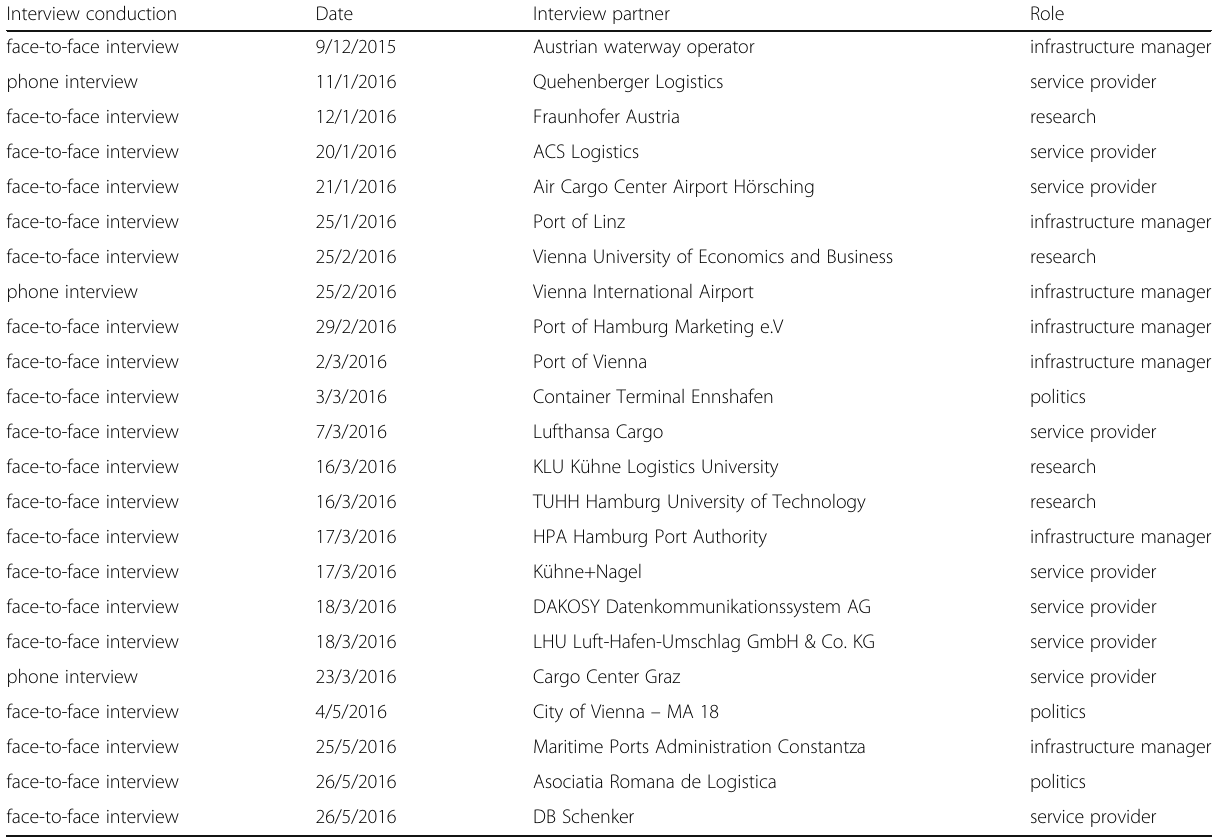
Table 2 Stakeholderinterviews Interview